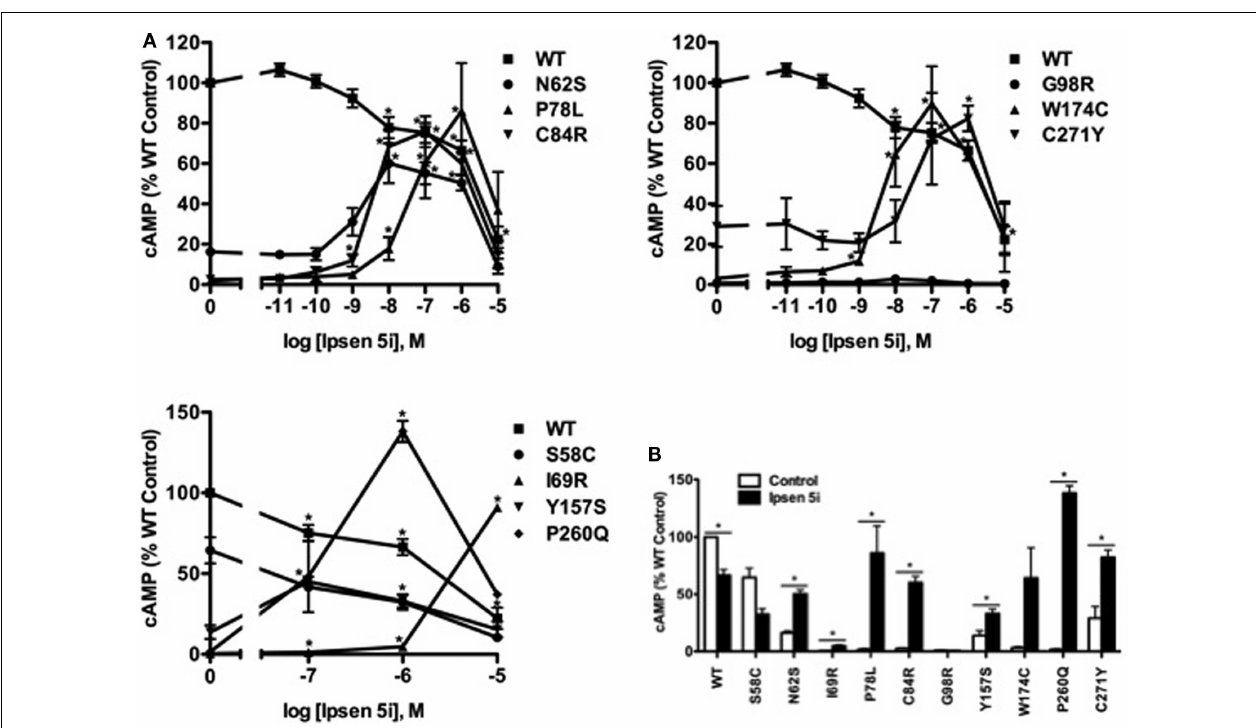
samples were collected and cAMP concentrations were measured using RIA. The results are expressed as % DMSO-treatedWT cAMP production. Data points are shown as mean ± SEM of at least two or three independent experiments. *Significantly different from the DMSO-treated control group, p <